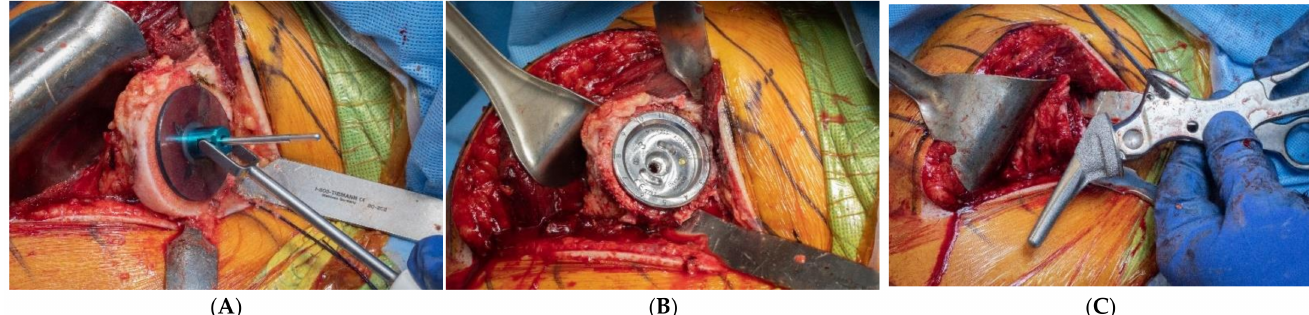
Figure 8. Primary component stability may be optimized by the implant fit at the periphery of the proximal humerus, within 2–4 mm of the cortical rim. ( A ), Sizing disk; ( B ), Trial; ( C ), Humeral